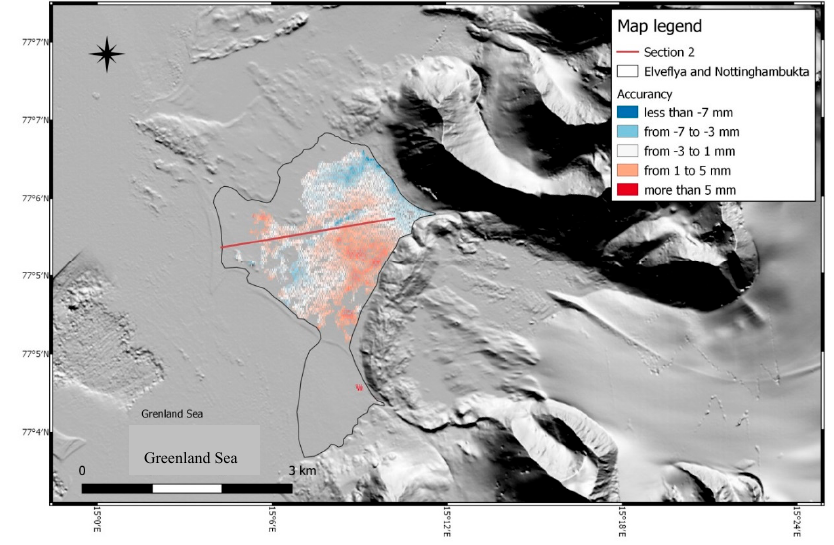
Figure A6. Accuracy of thee displacement determination on the entire surface of the elaboration. In the background, the Elveflya and Nottingham fans range and DEM from ArcticDEM https: // www.pgc.umn.edu / data / arcticdem /